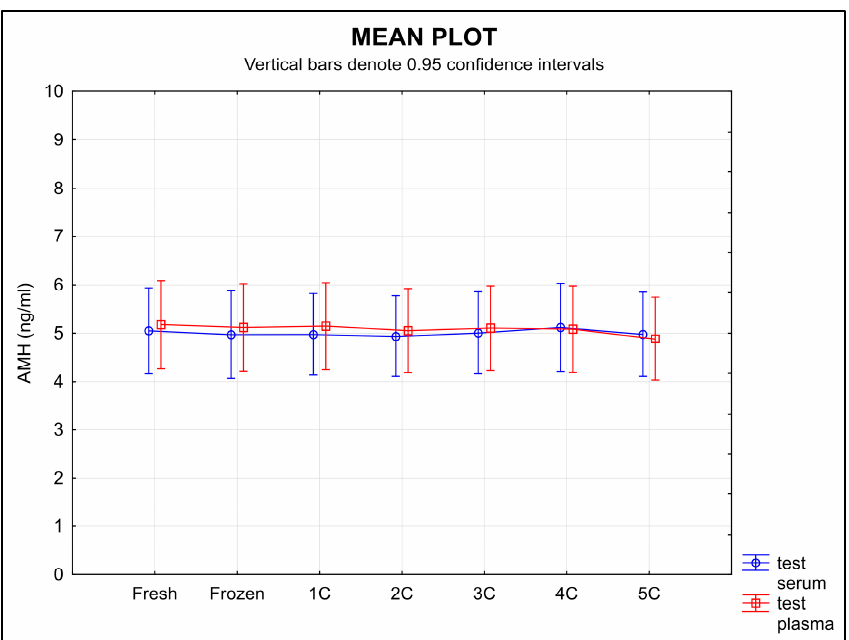
Figure 2. AMH stability during freezing in serum and plasma samples. Legend: The stability of the samples during freezing and thawing did not change over time in serum samples, whereas the sta ‐ bility of the plasma samples decreased over time. An equivalence test using a ±0.30 ng/mL limit of tolerance found equivalence only for serum ( p = 0.0196), but not for plasma ( p = 0.3778); 1C, 2C, 3C, 4C, 5C ‐ number of freeze–thaw cycles.